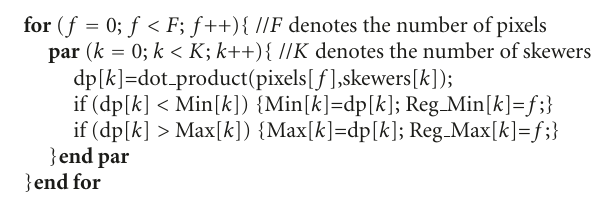
Algorithm 1: Parallel implementation of extreme projections